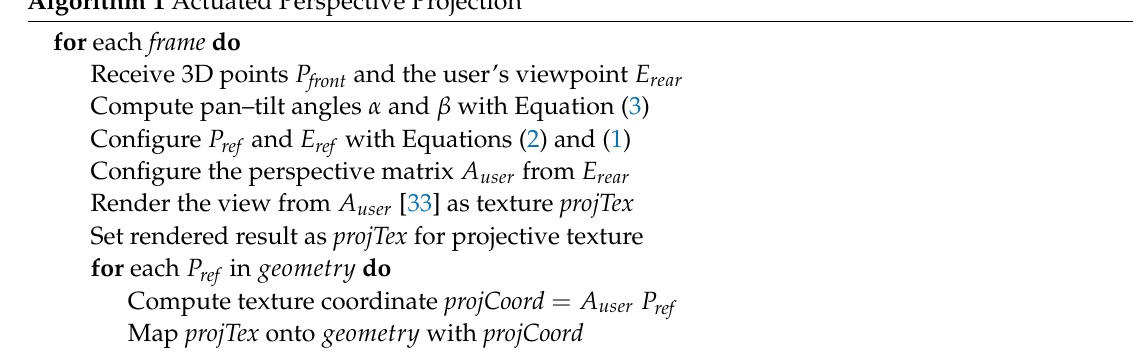
Algorithm 1 Actuated Perspective